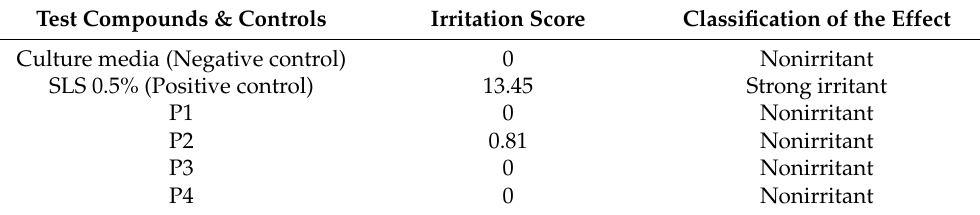
Table 4. Classification of the irritant potential of dental ceramic specimens (P1, P2, P3, P4) and